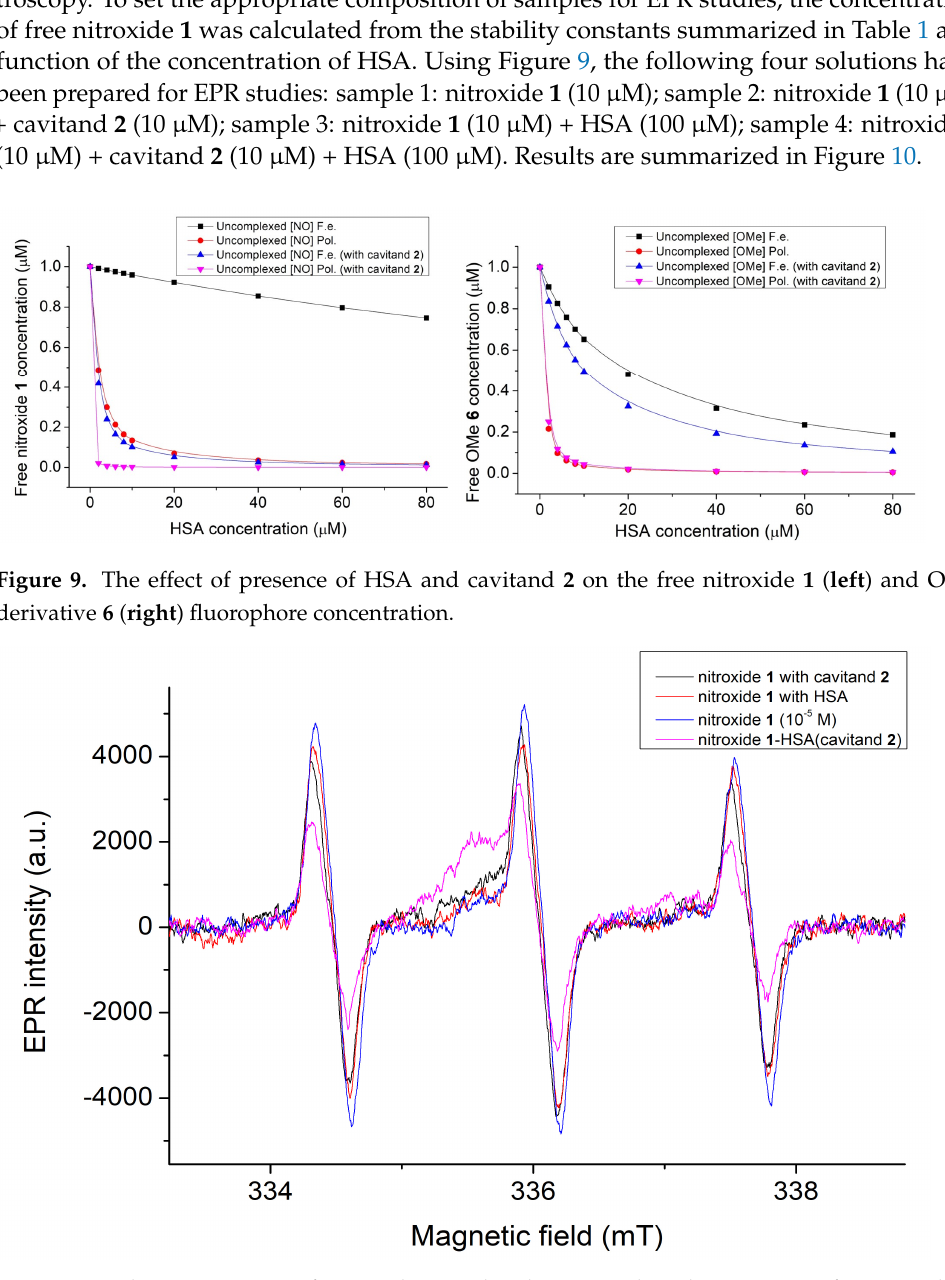
Figure 10. The EPR spectra of nitroxide 1 in the absence and in the presence of HSA and/or cavitand 2 . Distortion on the middle peaks in the presence of HSA and/or cavitand 2 confirms the complex formation.